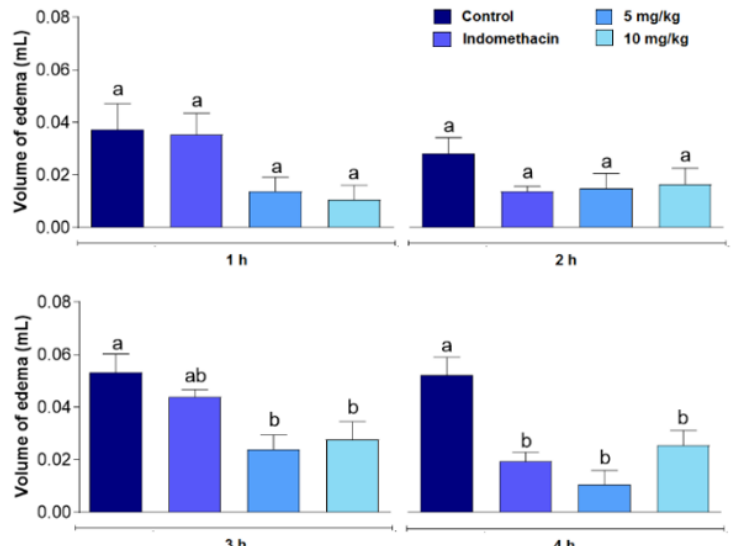
Figure 5. Anti-inflammatory effect of MvFL (5 and 10 mg/kg) and indomethacin (20 mg/kg) on carrageenan-promoted paw edema. Values are expressed as mean ± standard error of the mean ( n = 6). Different letters indicate significant ( p < 0.05) differences between treatments according to ANOVA followed by Tukey’s test.